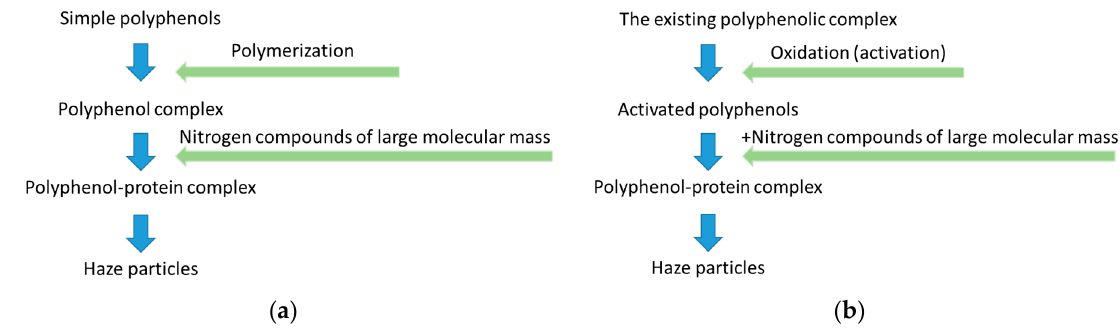
Figure 4. The two ( a , b ) hypothesis on beer colloidal haze formation.